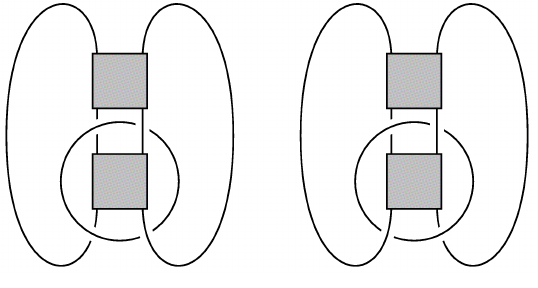
Fig. 1. The partially invertible 3-braids. The orientation and content of the boxes should be chosen so that the component(s) entering into the boxes form a closed 2-braid. One partial inversion of these links is then given by the (cid:25) -rotation along the vertical axis, which alters the orientation of the circular component not entering the